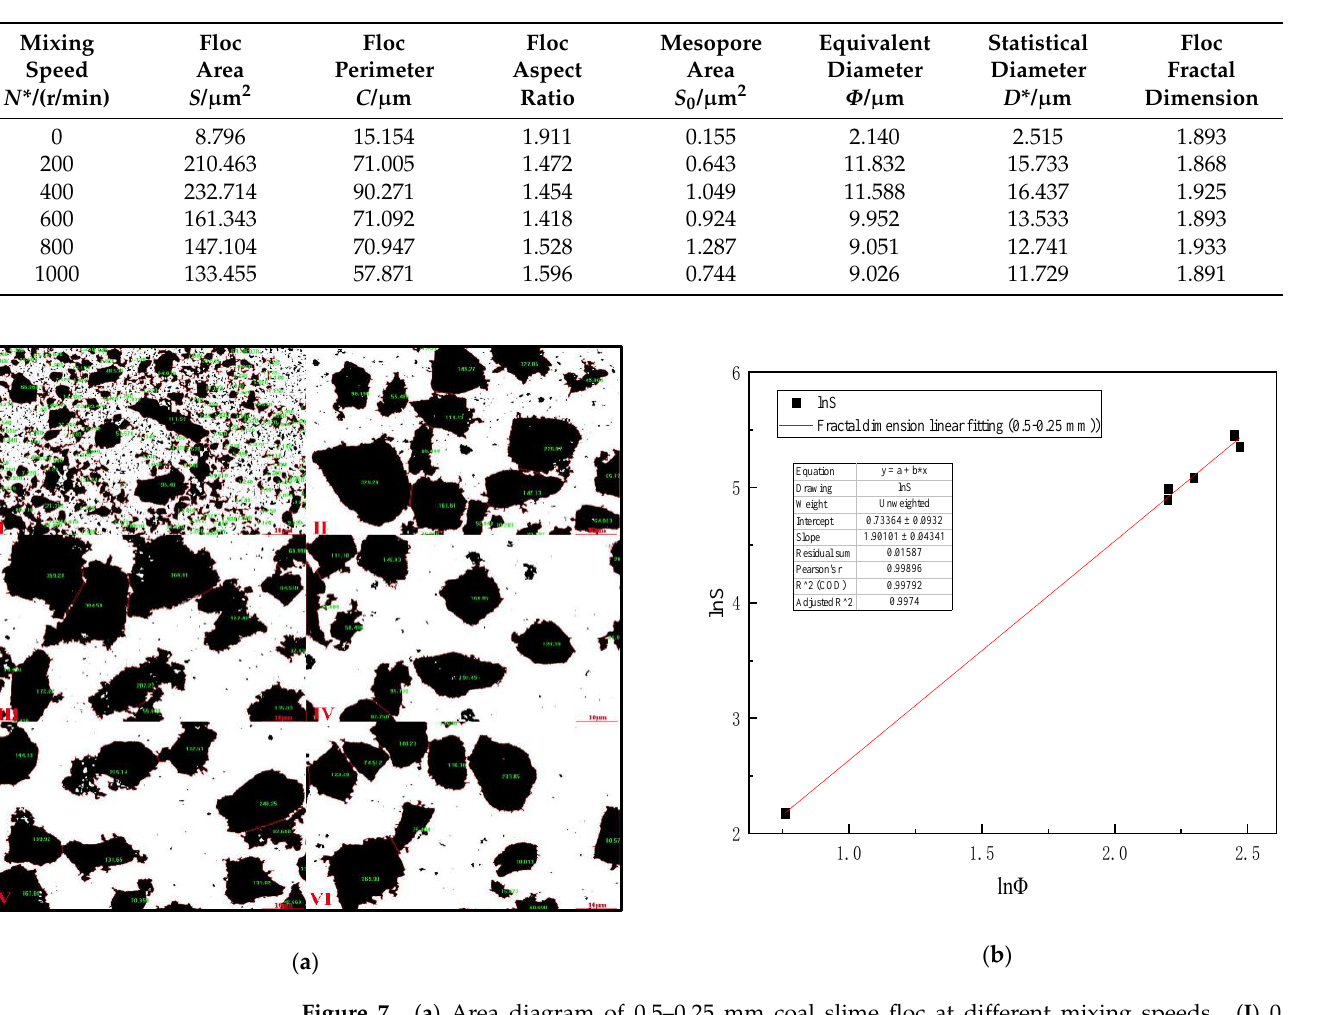
microscopic level. Figure 7a is the analysis diagram of floc area of 0.5–0.25 mm slime at the mixing speed of 0–1000 r/min. Figure 7b shows the fractal dimension fitting diagram, when the mixing speed is 0–1000 r/min, the mean fractal dimension of 0.5–0.25 mm coal slime floc is 1.901.